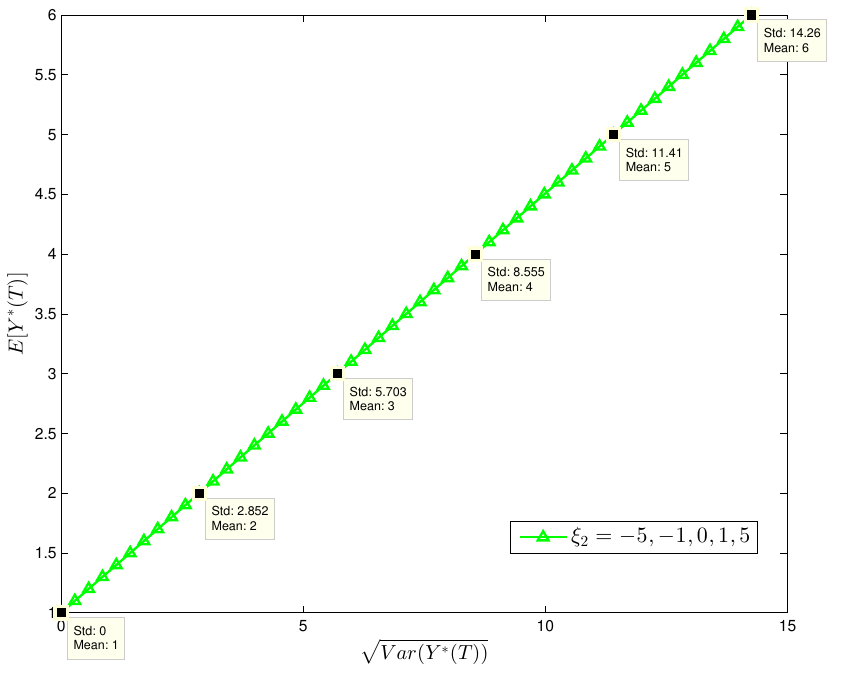
Figure 4. The efficient frontier in the incomplete market with different ξ 2 (In this figure, the values of (cid:112) V ar ( Y ∗ ( T )) corresponding to E [ Y ∗ ( T )] = i are reported, i = 1,2,3,4,5,6) .